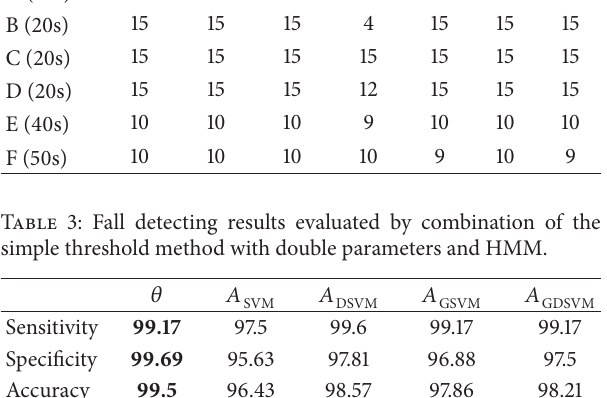
Figure 7: ROC curve of fall detection obtained from the simple and 𝜃 . threshold using the double fall-feature parameters of 𝐴 GSVM Thebestfalldetectionisofsensitivity97.92%,specificity94.38%,and = 2g and 𝜃 = 65 ∘ . accuracy 96.4% when 𝐴 GSVM